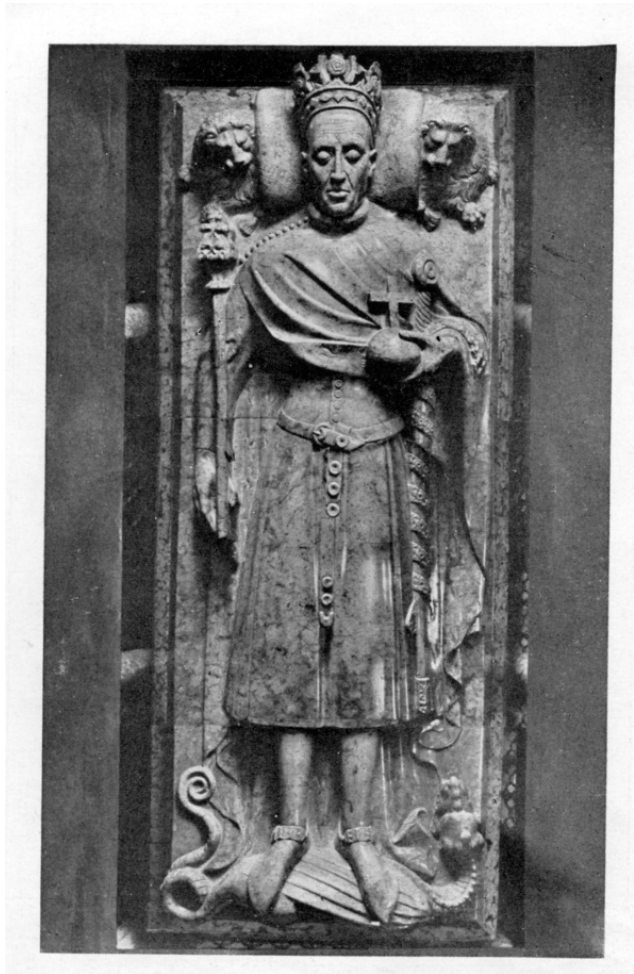
Figure 4. Tomb of Władysław Jagiełło, recumbent figure of the king, before 1430, Cracow, cathedral, the easternmost arcade between the nave and the south aisle, photo published in [37]. The decoration of the side walls of the tomb-chest is innovative with regard to the earlier royal tombs in Cracow. They are adorned with shields bearing the arms of the territories of the Polish Kingdom, and on the south side additionally flanked by pairs of mourning supporters, enclosed within square-shaped panels. The following heraldic devices have been represented on the long walls, starting from the head, on the south side: the White Eagle (arms of the land of Cracow and at the same of the entire Polish Kingdom), Pogo´n (arms of the Grand Duchy of Lithuania) and arms of the Dobrzy´n land; and on the north side: again, the Eagle and Pogo´n and the arms of Greater Poland. The shorter wall on the east, under the king’s feet, features the arms of Ruthenia: a lion, and the other one, on the west, under the king’s head, bears the arms of the Wielu´n land: an Agnus Dei with the Resurrection banner. The lands represented on the tomb-chest by means of their arms are territories that were either incorporated by Jagiełło into the Polish Kingdom (Grand Duchy of Lithuania) or permanently recovered for Poland through the king’s efforts (Red Ruthenia and the lands of Dobrzy´n and Wielu´n). The choice and arrangement of the heraldic devices on the tomb-chest alludes to the design of Jagiełło’s Great Seal, but here the set of arms was modified in order not only to display the territorial extent of Jagiełło’s rule as a lord of Poland and Lithuania, but also to emphasise the king’s personal achievement in fulfilling the electoral contract. Nor is it accidental that the short walls bear the arms of the lands of Dobrzy´n and Wielu´n, which—owing to the signs in their armorial bearings—apart from the political significance, emphasised also the eschatological meaning of the tomb. The